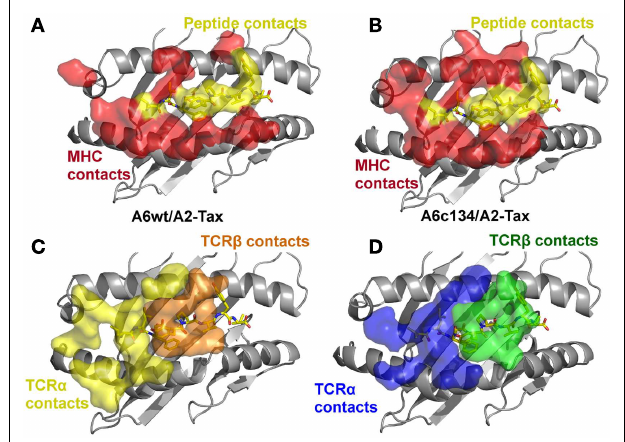
FIGURE 3 |The specific footprints made in theA6wtTCR/A2-Tax and A6c134TCR/A2-Tax complex structures are unique . (A) MHC (red surface) and peptide (yellow surface) residues that are contacted by the A6wtTCR. (B) MHC (red surface) and peptide (yellow surface) residues that are contacted by the A6c134TCR. (C) A6wtTCR residues (orange and yellow surface) that contact the pMHC. (D) A6c134TCR residues (blue and green surface) that contact the pMHC. Although the overall contact footprint is similar, the A6c134TCR makes new interactions with both the MHC surface and the